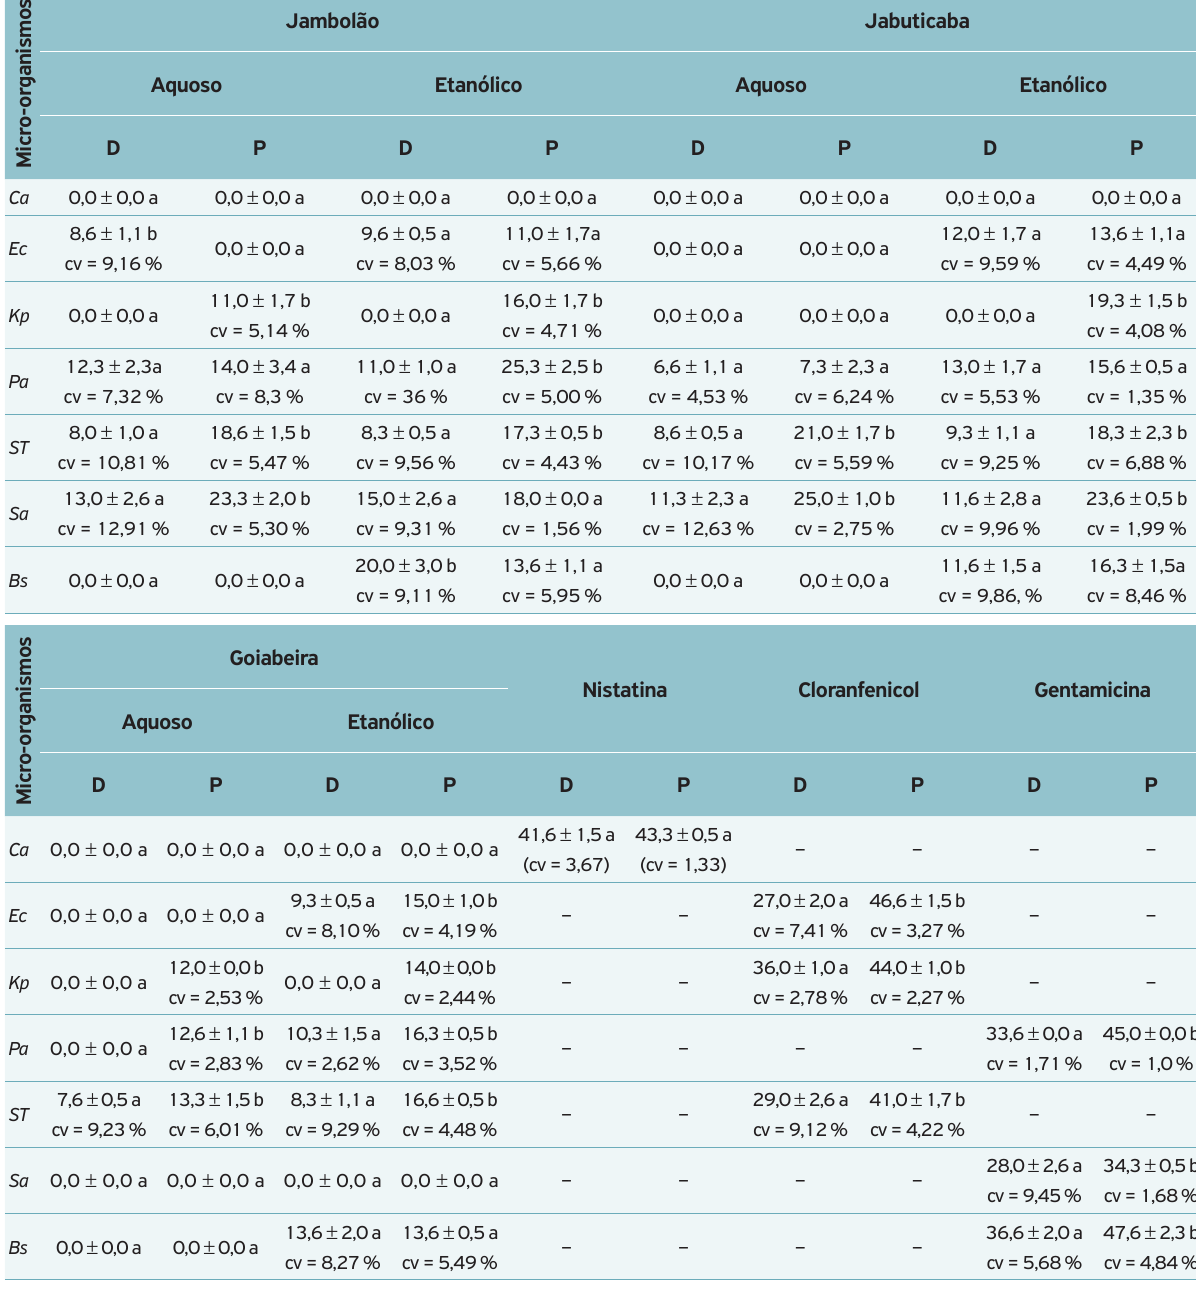
Tabela 1. Comparação entre as medidas dos diâmetros dos halos de inibição do crescimento microbiano (mm) obtidas pelas metodologias de disco e poço utilizando extratos de plantas aquosos e etanólicos ( Syzygium cumini, Myrciaria cauliflora e Psidium guajava ) e antimicrobianos comerciais (nistatina, cloranfenicol e gentamicina) frente a micro-organismos